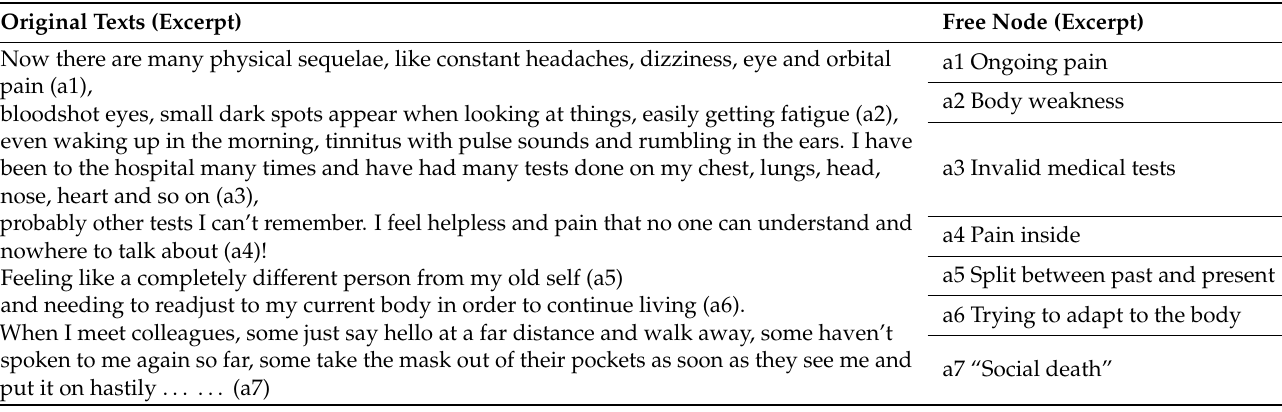
Table 1. Open Coding (Excerpt).